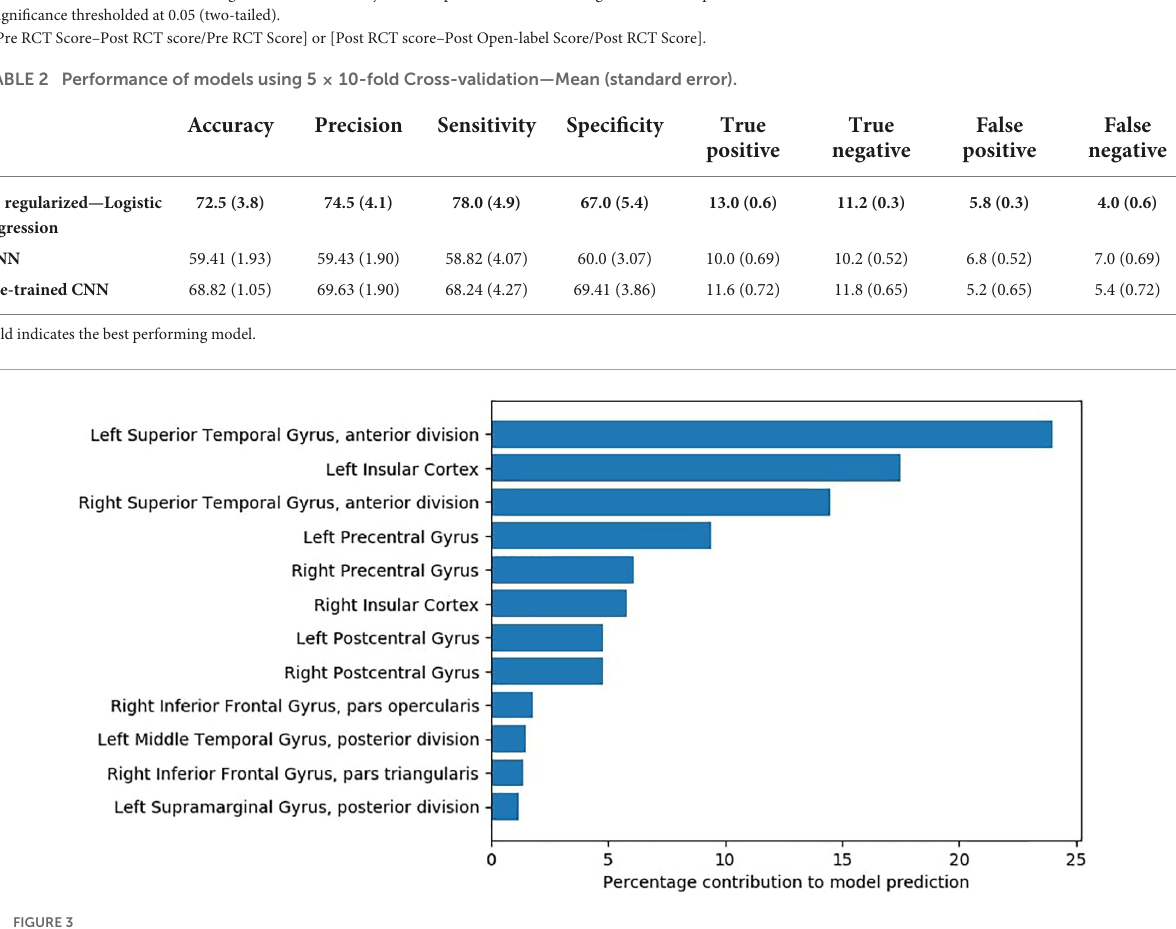
we observed that simpler logistic regression using a set of a priori target ROIs yielded superior results with an accuracy of 72.5%, precision of 74.5%, sensitivity of 78.0%, and specificity of